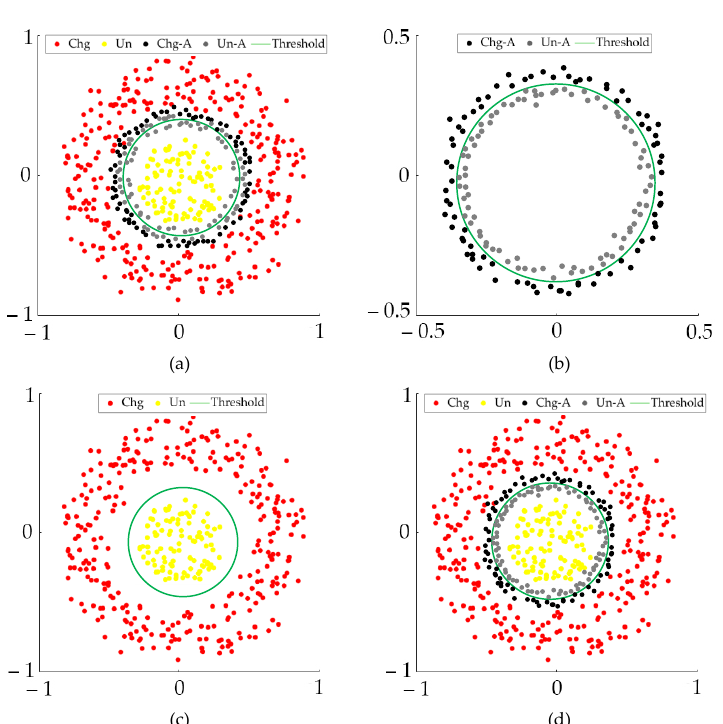
Figure 5. Visualization comparison of segmentation results by using discouraged subprocess and encouraged subprocess: ( a ) discouraged subprocess by merging AM-CPM and AL-CPM with US-